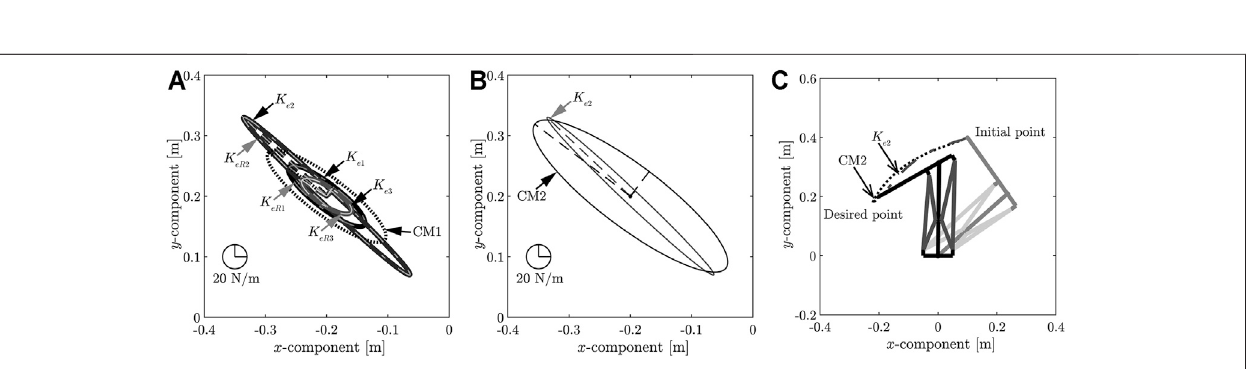
FIGURE4|(A) Comparisonofstiffnessellipsoidsobtainedusingeachdesiredend-pointstiffness. (B) Comparisonofstiffnessellipsoidsobtainedusingthedesired end-point stiffness K e 2 and CM2. (C) Comparison of loci of end-point positions at the desired end-point stiffnesses K e 2 and CM2.